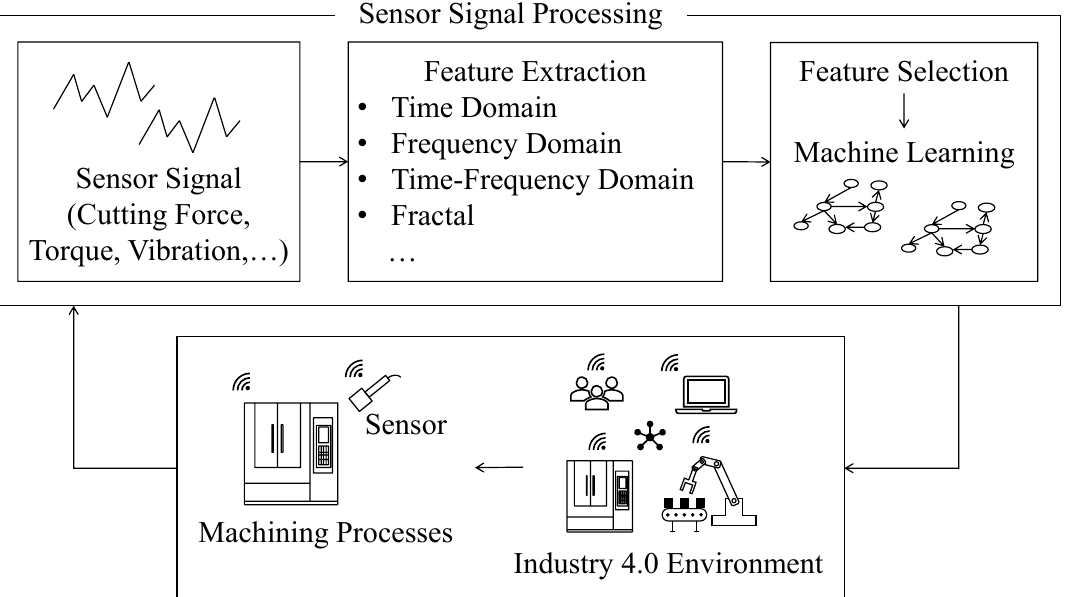
Figure 1. Context of sensor signal processing in Industry 4.0.